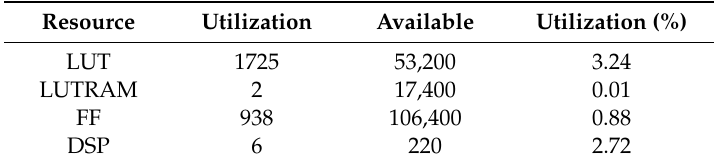
Table 1. Resource utilization in target FPGA for our CPU without approximate blocks.